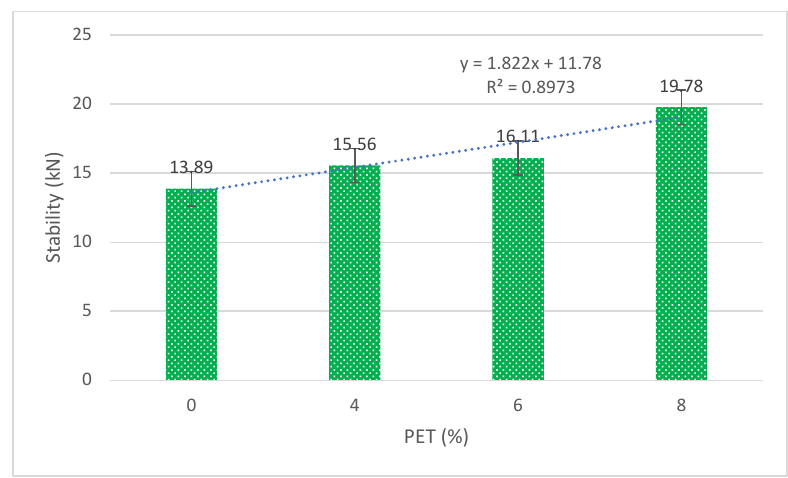
Figure 7. Stability of the PET-modified SMA asphalt mixtures.